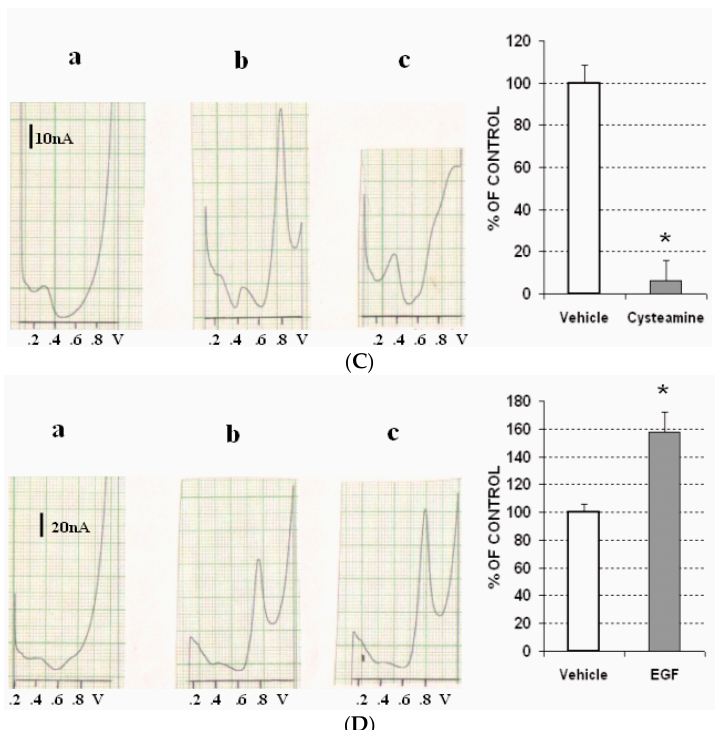
Figure 3. ( A ) Left: DPV-µCFE scans obtained in ( a ) vehicle (PBS); ( b ) in the gastric tissue of a single animal incubated with vehicle; ( c ) in the gastric tissue of a single animal incubated with aspecific IgG antisera (asp IgG). Note that the oxidation signal monitored at approximately .8 V (i.e., 800 mV) and measuring approximately 60 nanoAmperes (nA) superimposes the signal detected in the gastric tissue incubated with vehicle. Right, data obtained in antral preparation from 5 rats, incubated with vehicle or aspecific IgG antisera [asp IgG]; ( B ) Left: DPV-µCFE scans obtained in ( a ) vehicle (PBS); ( b ) in the gastric tissue of a single animal incubated with vehicle; ( c ) in the gastric tissue of a single animal incubated with specific IgG antisera (SRIF IgG); note that the peak monitored at +800 mV (denoted as peak 3 in this figure) and having a size of approximately 60 nA is no longer detected following incubation with specific IgG antiSRIF [peaks 1 and 2 are detected at lower oxidation potential, i.e., +200 or +400 mV, respectively, and are not affected by SRIF IgG]. Right, data obtained in antral preparation from 5 rats, incubated with vehicle or specific IgG antisera; ( C ) Left: DPV-µCFE scans obtained in ( a ) vehicle (PBS); ( b ) in the gastric tissue of a single animal incubated with vehicle; ( c ) in the gastric tissue of a single animal incubated with cysteamine; note that the peak monitored at +800 mV is greatly decreased. Right, data obtained in antral preparation from 5 rats, incubated with vehicle or cysteamine; ( D ) Left: DPV-µCFE scans obtained in ( a ) vehicle (PBS); ( b ) in the gastric tissue of a single animal incubated with vehicle; ( c ) in the gastric tissue of a single animal incubated with EGF: note that the peak monitored at +800 mV is significantly increased, i.e., from approximately 60 nA to approximately 85 nA.